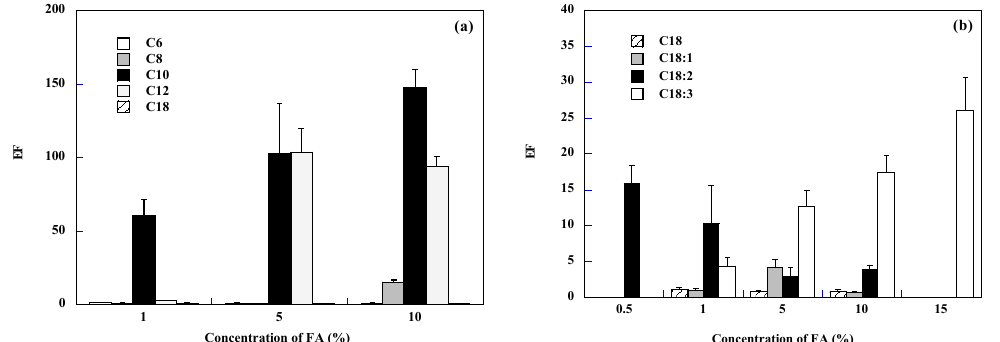
Figure 2. Effect of fatty acid concentration (Panel ( a ) saturated; Panel ( b ) C18 saturated and unsaturated) on the permeation of FD-4 across pig esophageal epithelium. Mean values ± SEM.